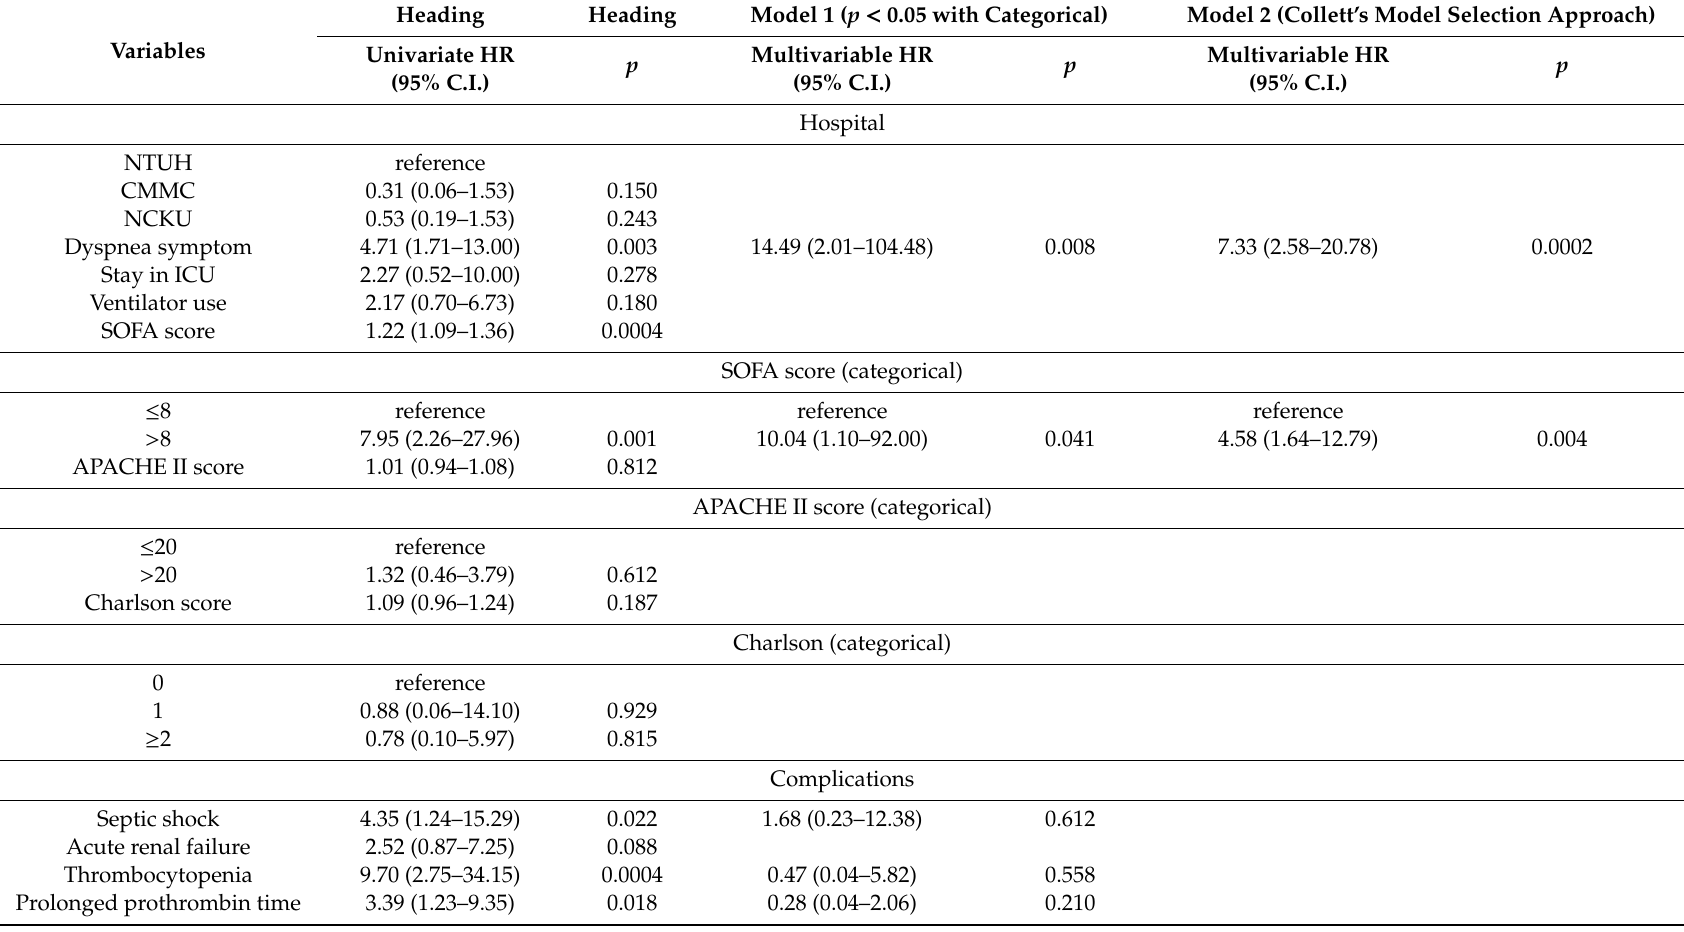
Table 4. Hazard ratio of 30 days mortality after end of therapy using the Cox regression